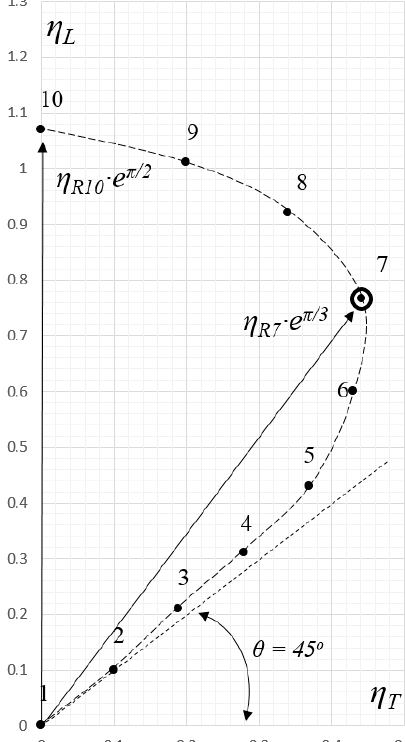
Figure 12. A history polar presenting a hypothetical linear initial behavior and a thrust inflection point.